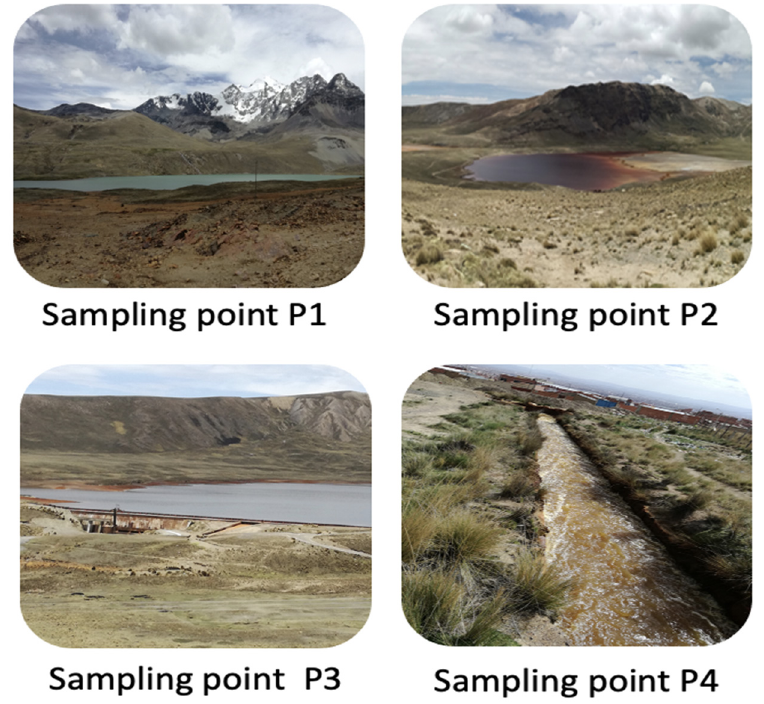
Figure 4. Sampling points in Milluni.